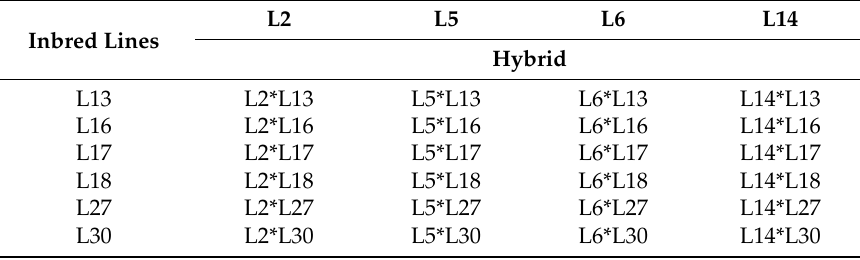
Table 2. List of inbred lines and hybrids produced from crossing the parental